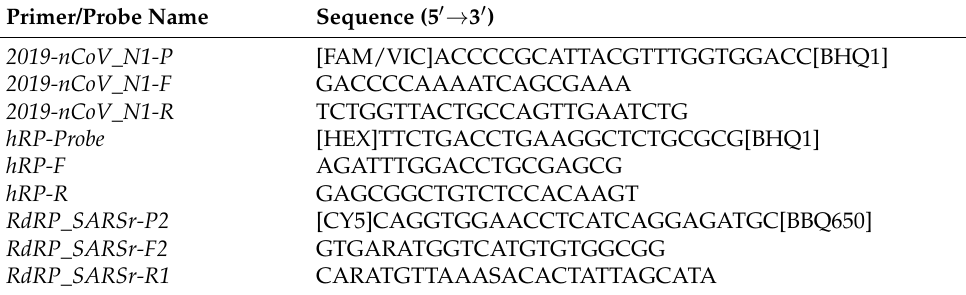
Table 1. Primer and dual-labeled probe sequences used for multiplex RT-qPCR